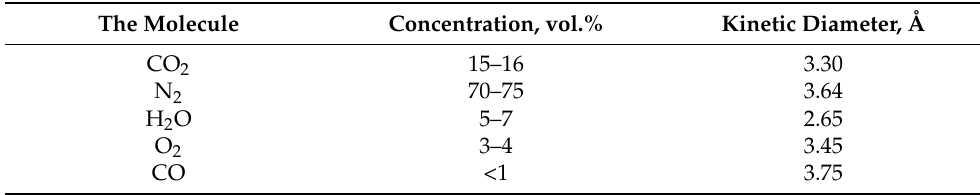
Table 1. Composition and kinetic diameters of gas molecules that make up a typical flue gas of a coal-fired power plant [7]. The Molecule Concentration, vol.% Kinetic Diameter, Å CO